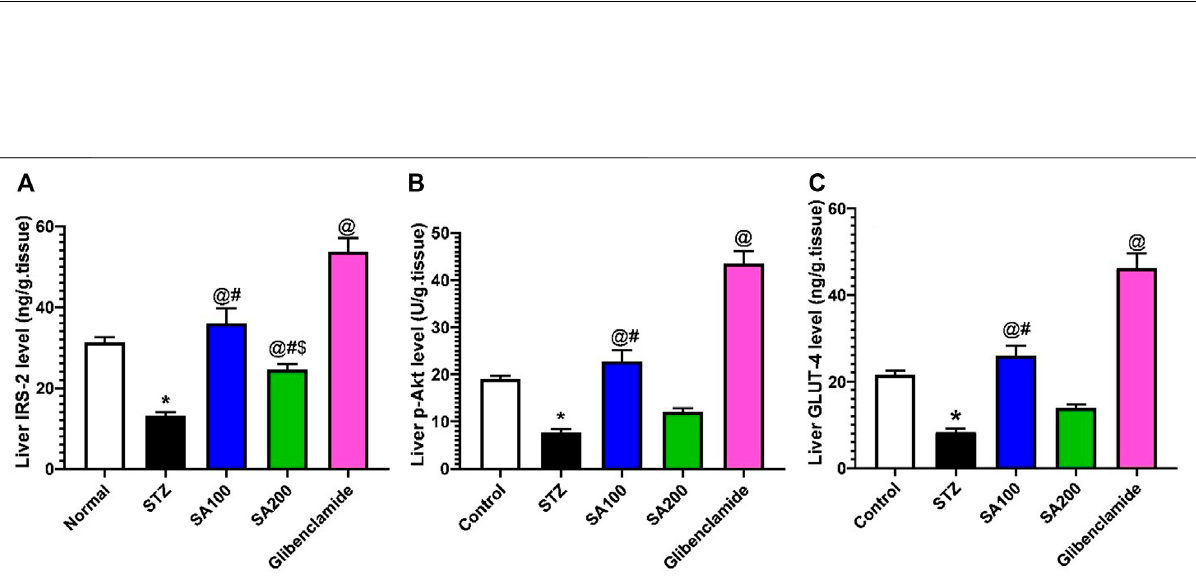
Frontiers in Pharmacology |